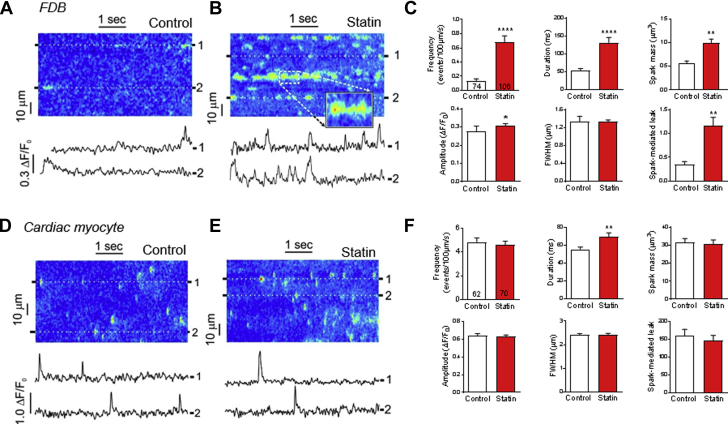
Statin Treatment Provokes SR Ca2+ Leak in Skeletal, But Not Cardiac, MyocytesRepresentative confocal line scans (F/F0) with associated line profiles and mean data from (A to C) intact flexor digitorum brevis (FDB) fibers and (D to F) cardiac myocytes; n = 11/10 (FDB) and 5/5 (cardiac myocytes) rats for control/statin-treated groups, number of cells shown on graphs. Data are mean + SEM and compared using the Mann-Whitney rank test. (C) ****p < 0.0001; *p = 0.0307; **p = 0.0029 (mass); **p = 0.0091 (leak). (F) **p = 0.0024. Ca2+ = calcium; FWHM = full width at half maximum; SR = sarcoplasmic reticulum.